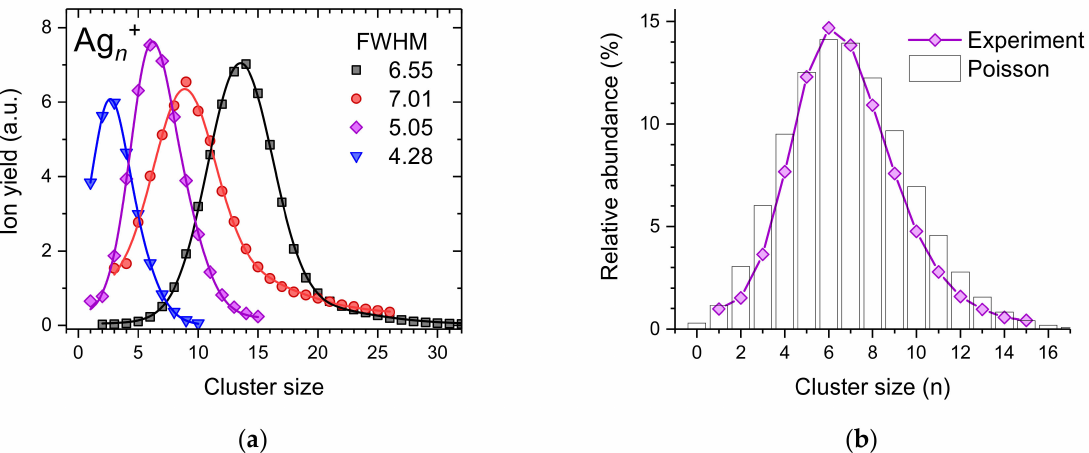
Figure 1. ( a ) Measured size distributions of cationic silver clusters formed upon pickup into charged helium droplets (symbols). The lines are fits to the data using a superposition of two Gaussian peak functions; ( b ) Comparison of one measured cluster size distribution with a Poisson distribution having an expectation value of λ =